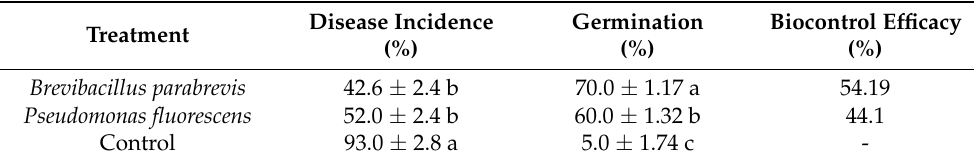
Table 5. Biocontrol efficacy of Brevibacillus parabrevis and Pseudomonas fluorescens against Fusarium oxysporum f in pot experiments.